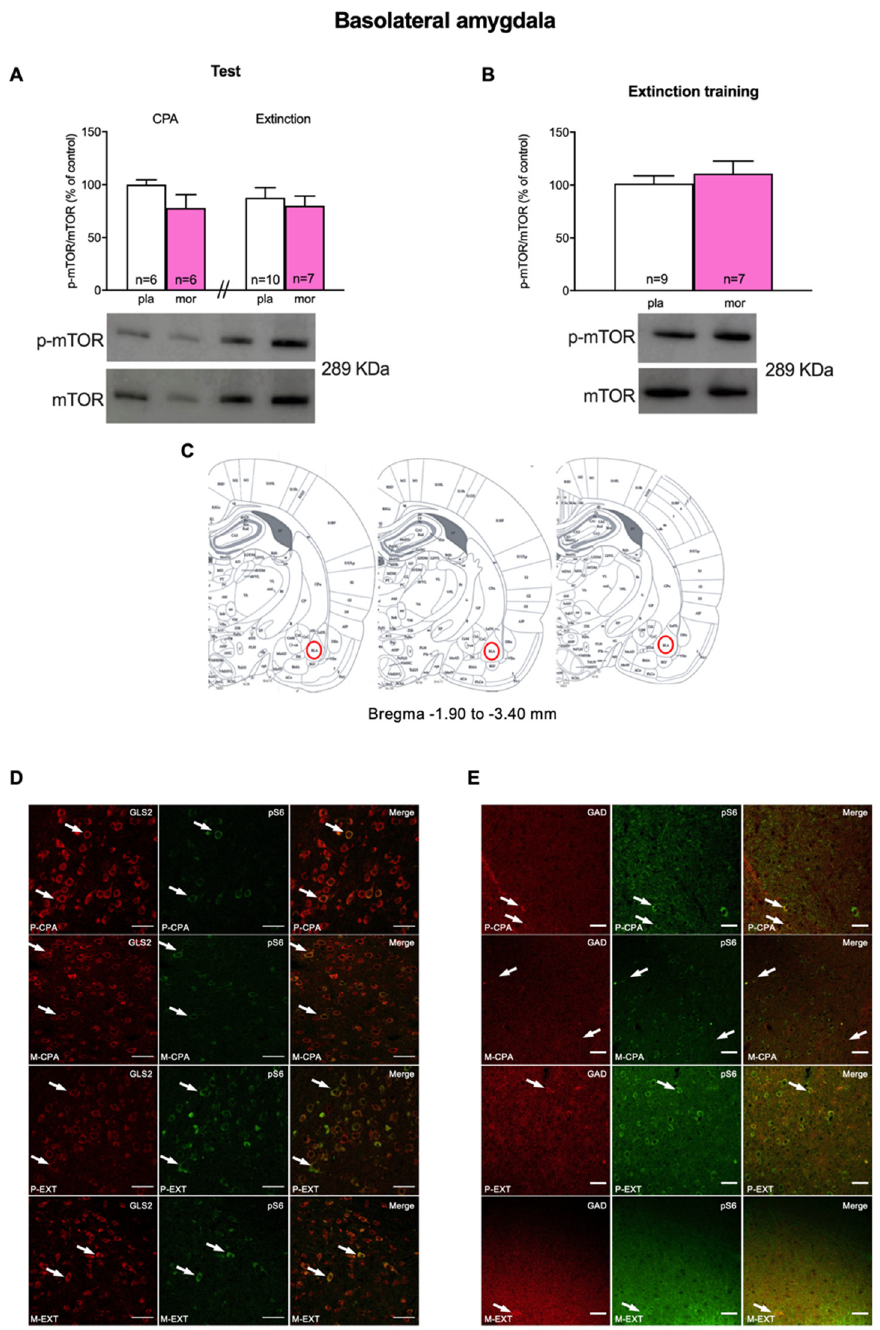
Figure 2. Basolateral amygdala: ( A ) p-mTOR/mTOR Western blot analysis after CPA and extinction tests. ( B ) pmTOR/mTOR analysis after extinction training procedures. ( C ) Anatomical localization of basolateral amygdala in the rat brain. ( D ) Colocalization of glutamatergic neurons (GLS2, red) and phosphorylated target of mTOR p-S6. ( E ) Colocalization of GABAergic neurons (GAD, red) and phosphorylated target of mTOR p-S6 (green). Each bar corresponds to mean ± SEM.